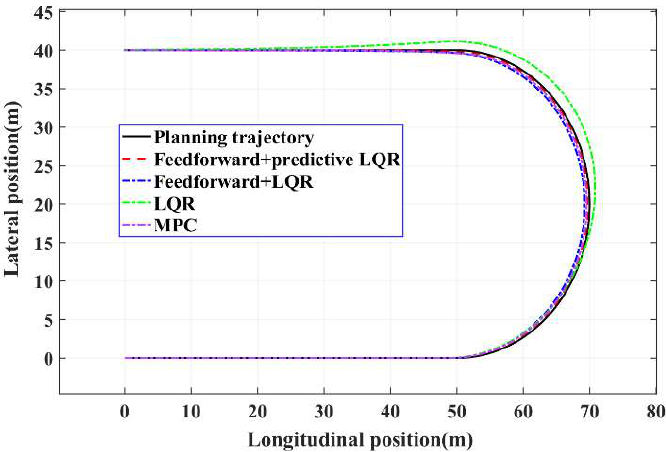
( a ) Planning path tracking results. Figure 8. Cont